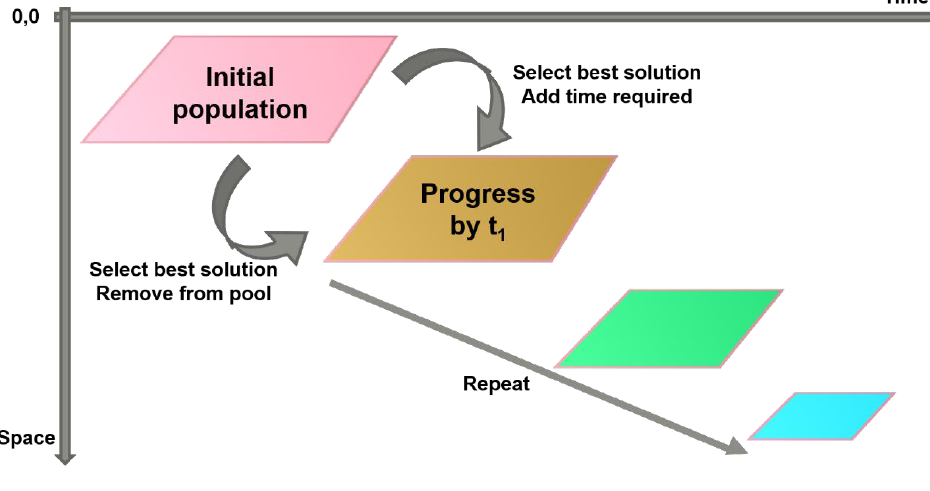
Figure 5. Inverse pyramid solution approach.